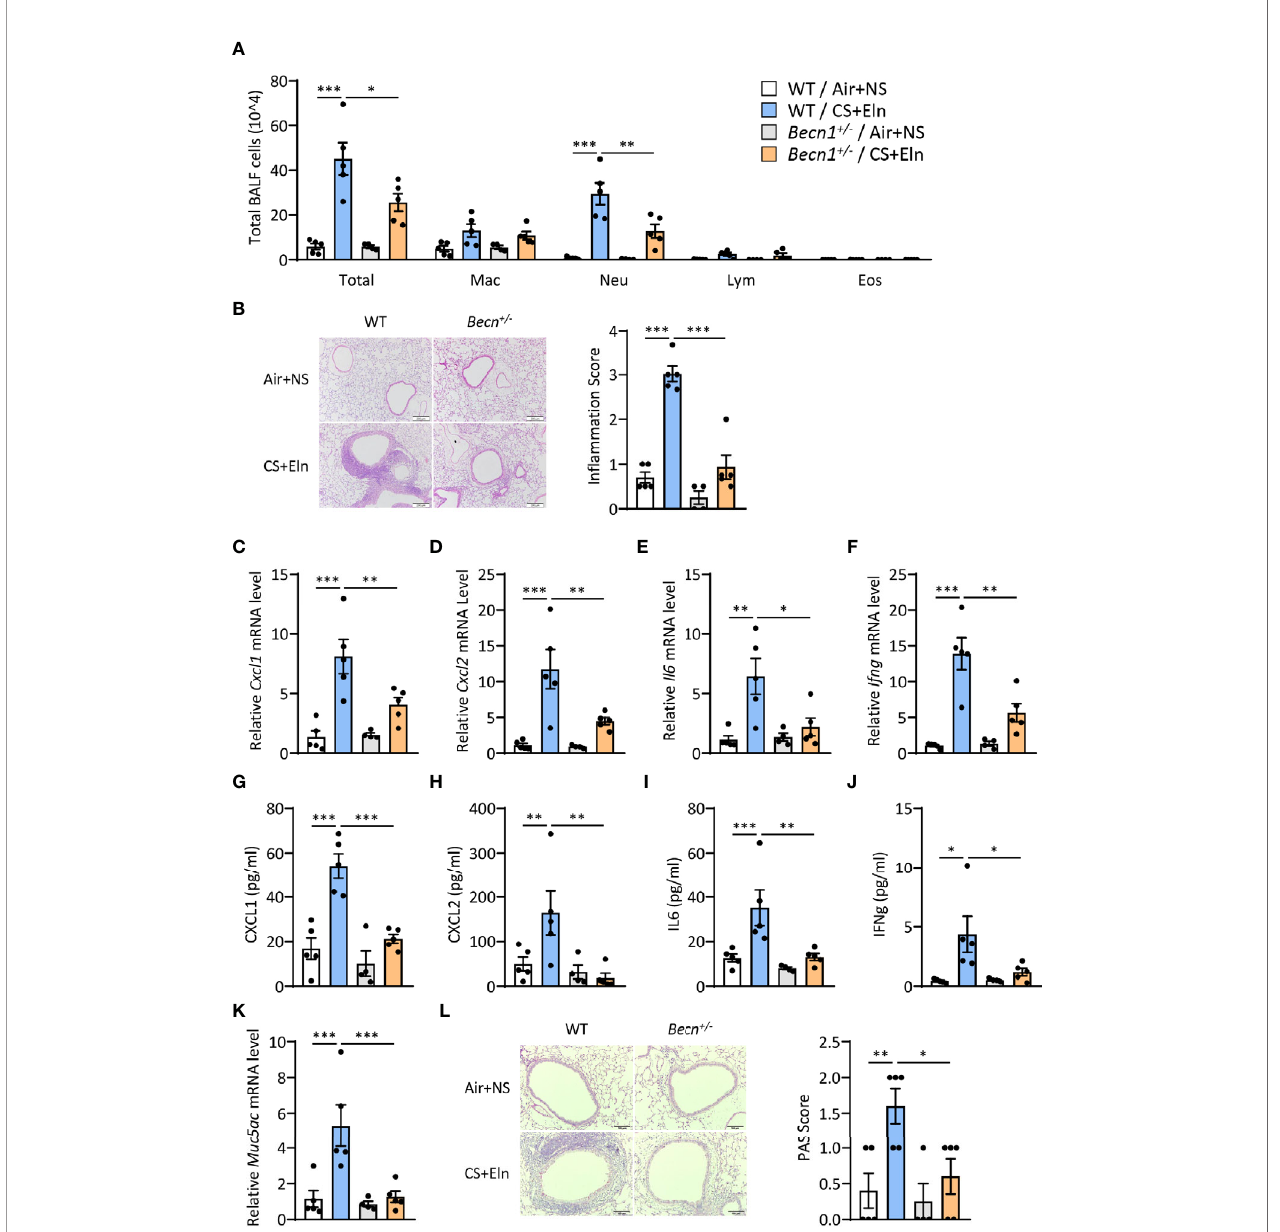
FIGURE 2 | Impairment of Becn +/- attenuates the bronchitis-like phenotypes in the CS+Eln model. Experimental outline was the same as Figure 1A , (A) In fl ammatory cell counts in the BALF. (B) Representative images and semi-quanti fi ed scoring of H&E staining of mouse lung sections. Scale bar = 200 m m. (C – F) The Cxcl1 , Cxcl2 , Il6 and Ifng mRNA transcripts in lungs. (G – J) The protein concentrations of CXCL1, CXCL2, IL6 and IFNg in BALF. (K) Expression of Muc5ac mRNA transcripts in mouse lungs. (L) Representative images and the semi-quanti fi ed scorings of PAS staining in mouse lung sections. Scale bar = 100 m m. Labeling for all the columns throughout Figure 2 was shown in (A) . Mac, macrophages; Neu, neutrophils; Lym, lymphocytes; Eos, eosinophils. Throughout, data are representative of 4-5 mice and were replicated in at least 3 independent experiments. Data are presented as mean ± s.e.m. * p < 0.05, ** p < 0.01, *** p < 0.001 by one-way